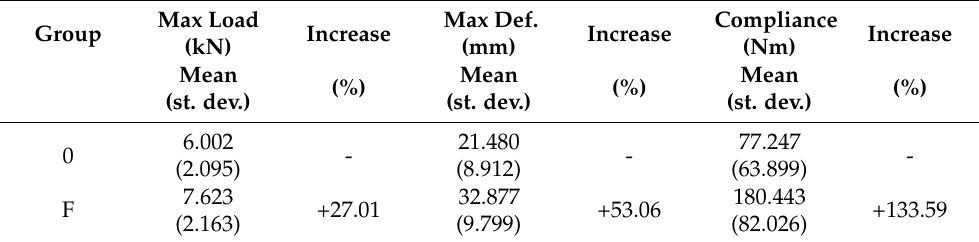
Table 5. Mean values and standard deviations of the maximum loads, deflections, and compliance in all groups, and increase with respect to non-reinforced